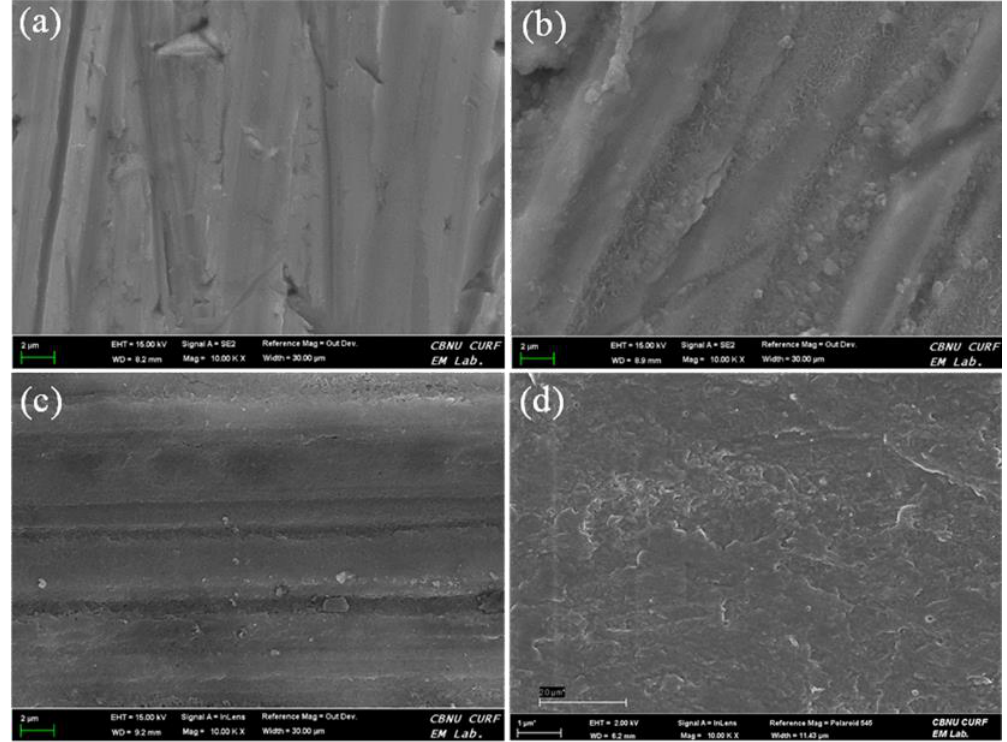
Figure 1. FE-SEM images showing surface topography of ( a ) pure Mg, ( b ) Mg-OH, ( c ) Mg-OH-AA, and ( d ) Mg-OH-AA-BSA before the evaluation of potentiodynamic polarization test.